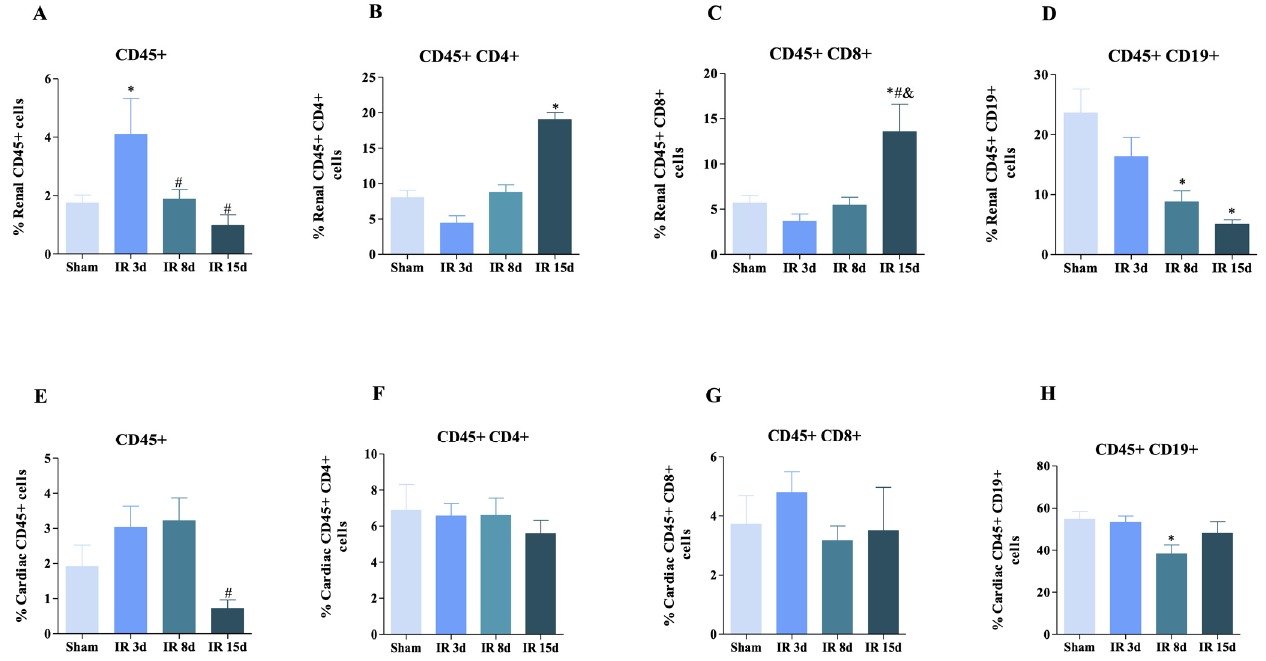
Figure 2. T and B lymphocyte populations are increased in renal and cardiac tissue after renal I/R. Frequency of CD45+, CD4, CD8 e CD19 in the kidney ( A–D ) and in the cardiac tissue ( E–H ): ( A )